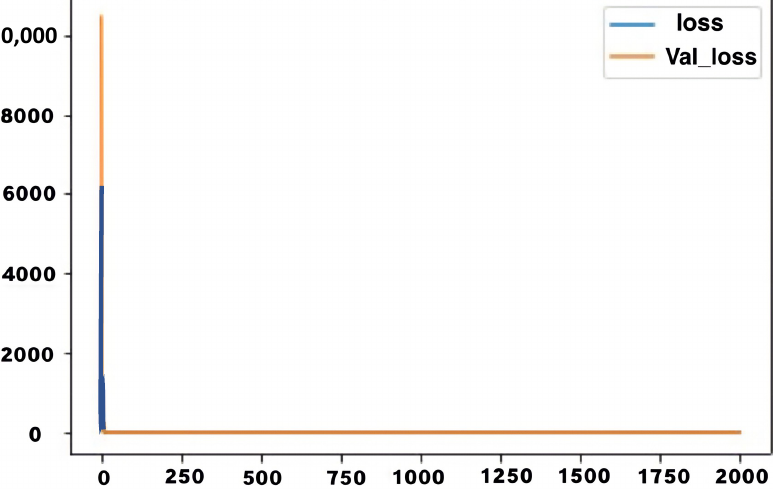
Figure 21. Loss against the number of epochs in training and testing of the second LSTM model.